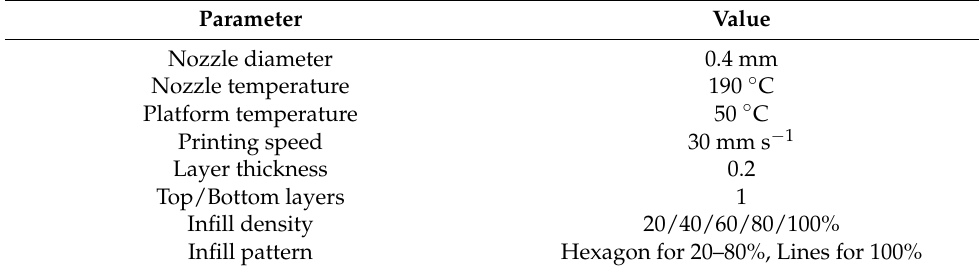
Table 1. Printing parameters of PLA/PCL 4D samples.